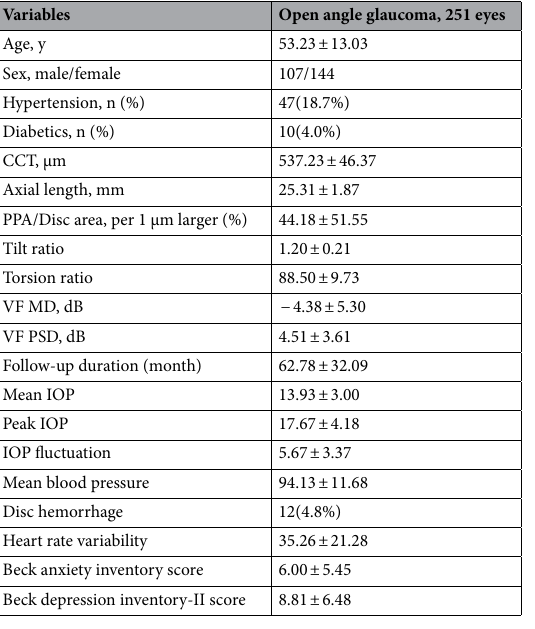
Table 1. Baseline demographics of patients with glaucoma. CCT, central corneal thickness; PPA, peripapillary atrophy; VF, visual field; MD, mean deviation; PSD, pattern standard deviation; IOP, intraocular pressure. Continuous data are mean ± mean standard deviation unless otherwise